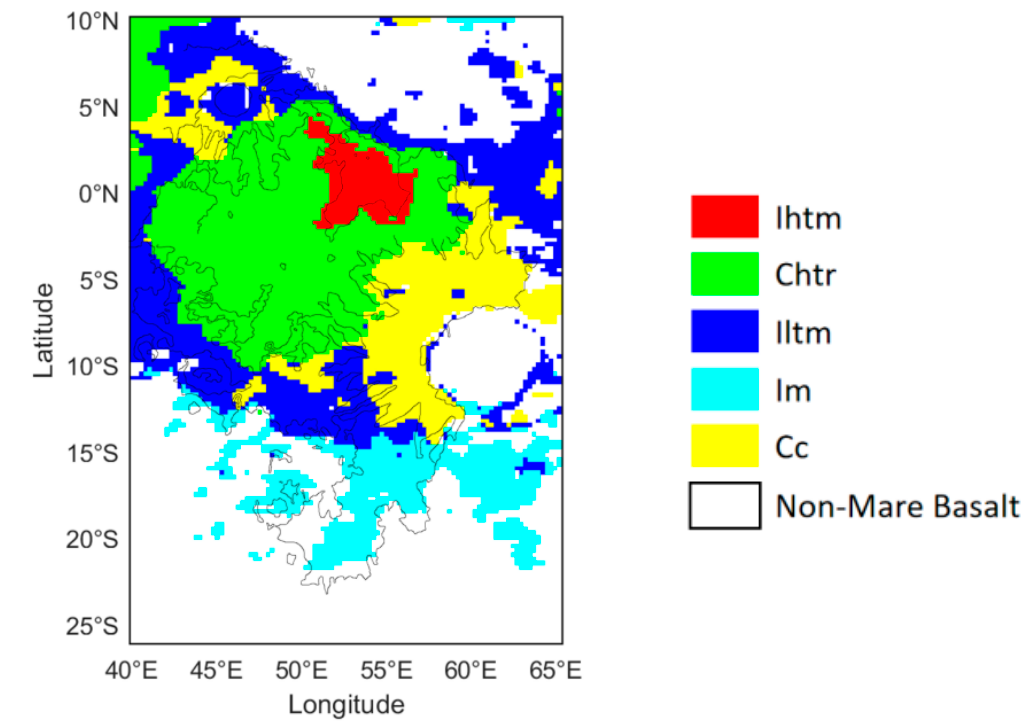
Figure 12. Random Forest Classi fi cation result for all original features.